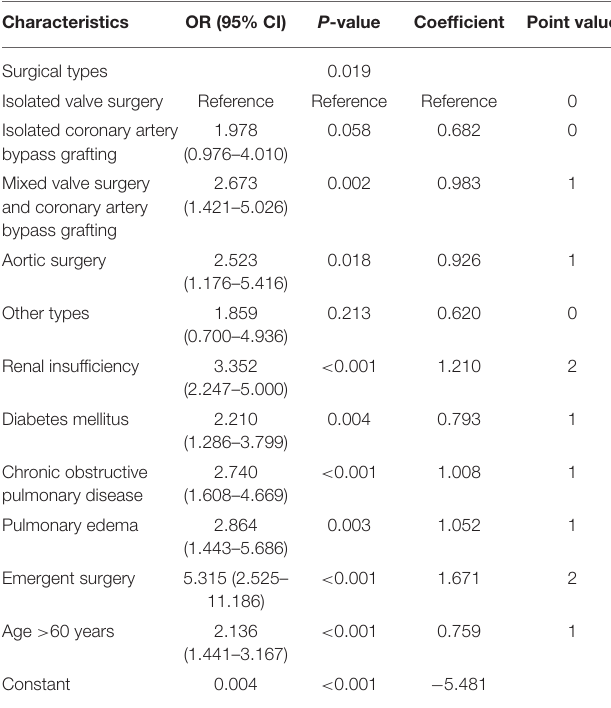
TABLE 3 | Multivariable analysis of independent risk factors for POT after cardiac surgery, with dichotomy of the continuous variables. Characteristics